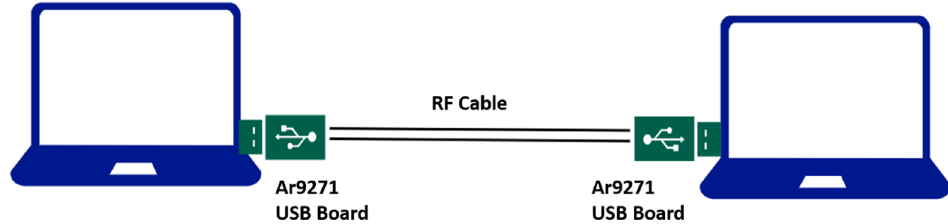
Figure 7. Proposed Station Framework.